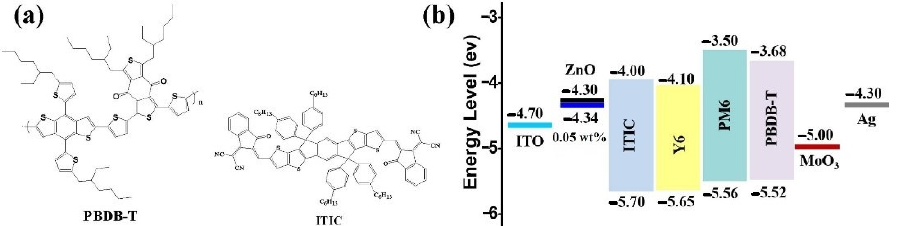
Figure 4. ( a ) Chemical structures of PBDB-T and ITIC. ( b ) Band diagram of the materials used in